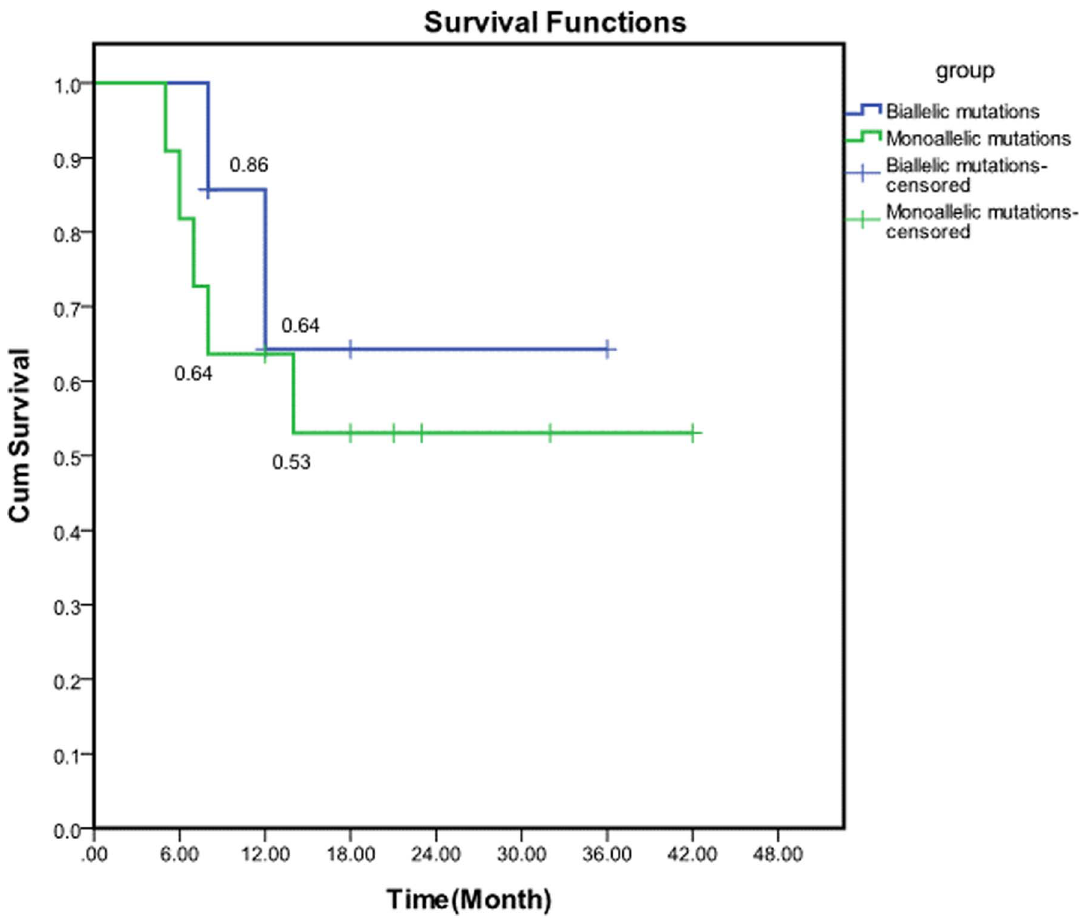
Figure 1. Comparison of the survival rate in the two groups.